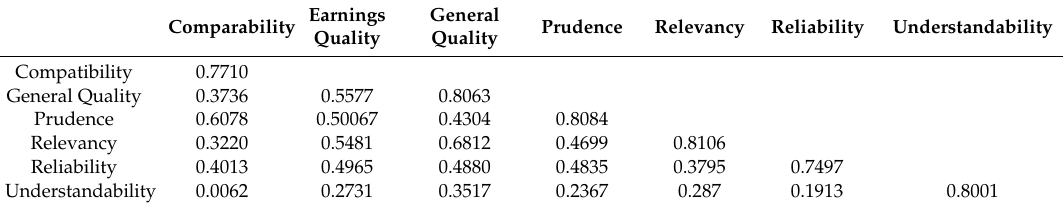
Table 4. Fornell-Larcker Criterion.